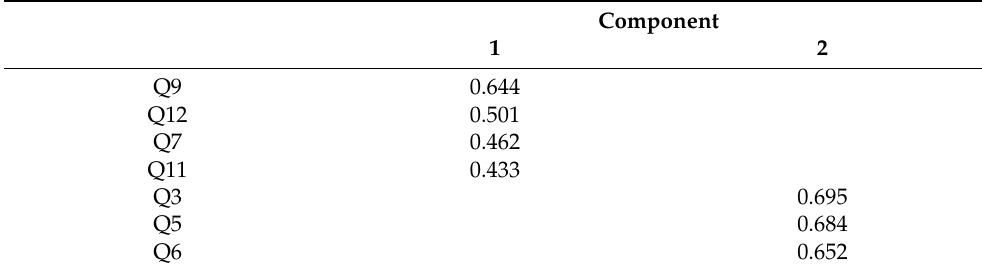
Table 11. Matrix of rotated components excluding the questions with less incidence in responding to the phenomenon under